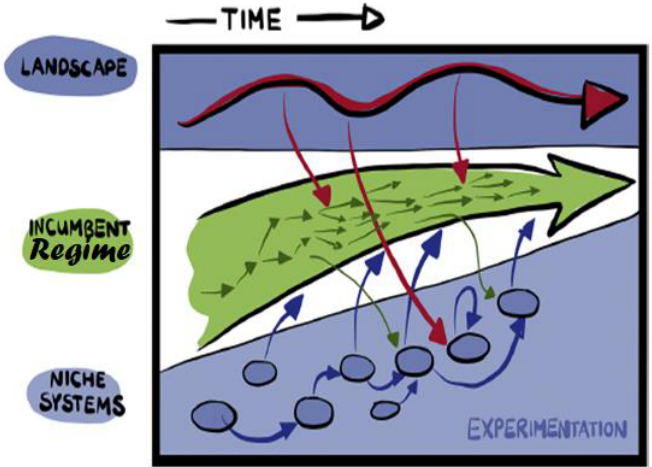
Figure 1. Visualization of the MLP and dynamics of the socio-technical regimes. Source: Reprinted with permission from van Rijnsoever et al. [34]. 2020, Elsevier.